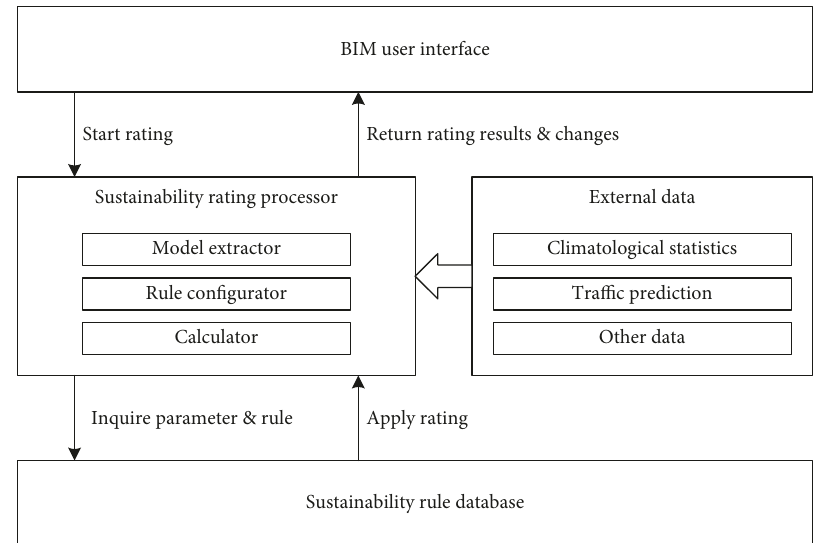
Figure 1: A framework integrating BIM and sustainable infrastructure rating